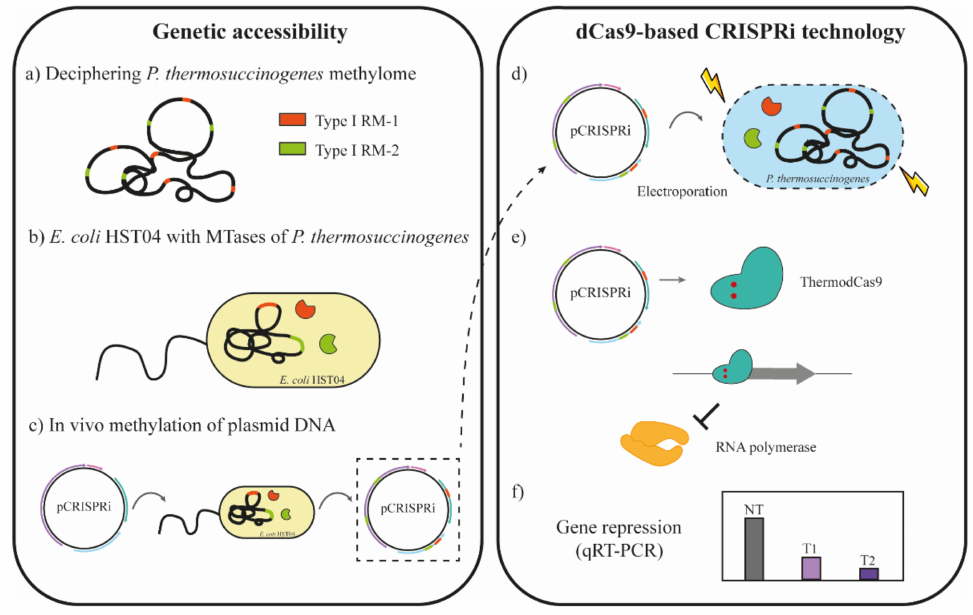
Figure 1. Schematic overview for in vivo methylation and CRISPRi application for P. thermosuccino- genes DSM 5809. ( a ) The genome sequence and methylome of P. thermosuccinogenes was used to identify the native restriction modification (RM) systems. Three different RM systems were identified in P. thermosuccinogenes DSM 5809, but only two are depicted in the figure. ( b ) A set of E. coli HST04 derivative strains was constructed by cloning of the methyltransferase genes (orange and green) of P. thermosuccinogenes . ( c ) The ThermodCas9 plasmid of interest (pCRISPRi) was introduced in these E. coli strains by electroporation. The methylated pCRISPRi plasmid DNA was isolated from this strain and ( d ) electroporated into P. thermosuccinogenes . In this way, the pCRISPRi presents a methylation pattern similar to that of the genome of P. thermosuccinogenes , overcoming the restriction barrier. ( e ) pCRISPRi expresses the ThermodCas9 and the sgRNA, downregulating the gene of interest upon recognizing and binding the target DNA (promoter region). Transcription is blocked since the Cas9 protein physically interferes with the RNA polymerase. ( f ) Gene repression of desired gene was evaluated by